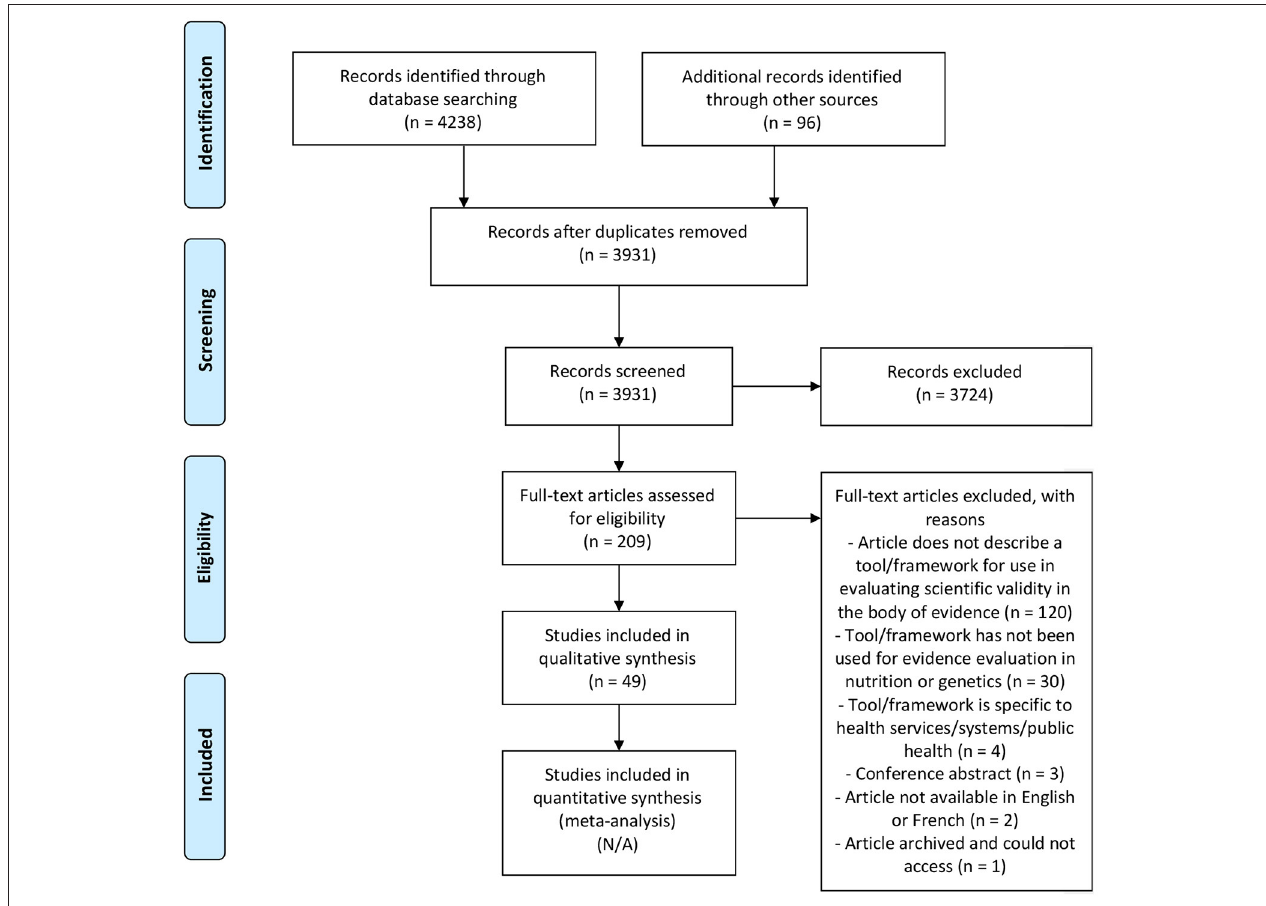
FIGURE 1 | PRISMA 2009 flow diagram